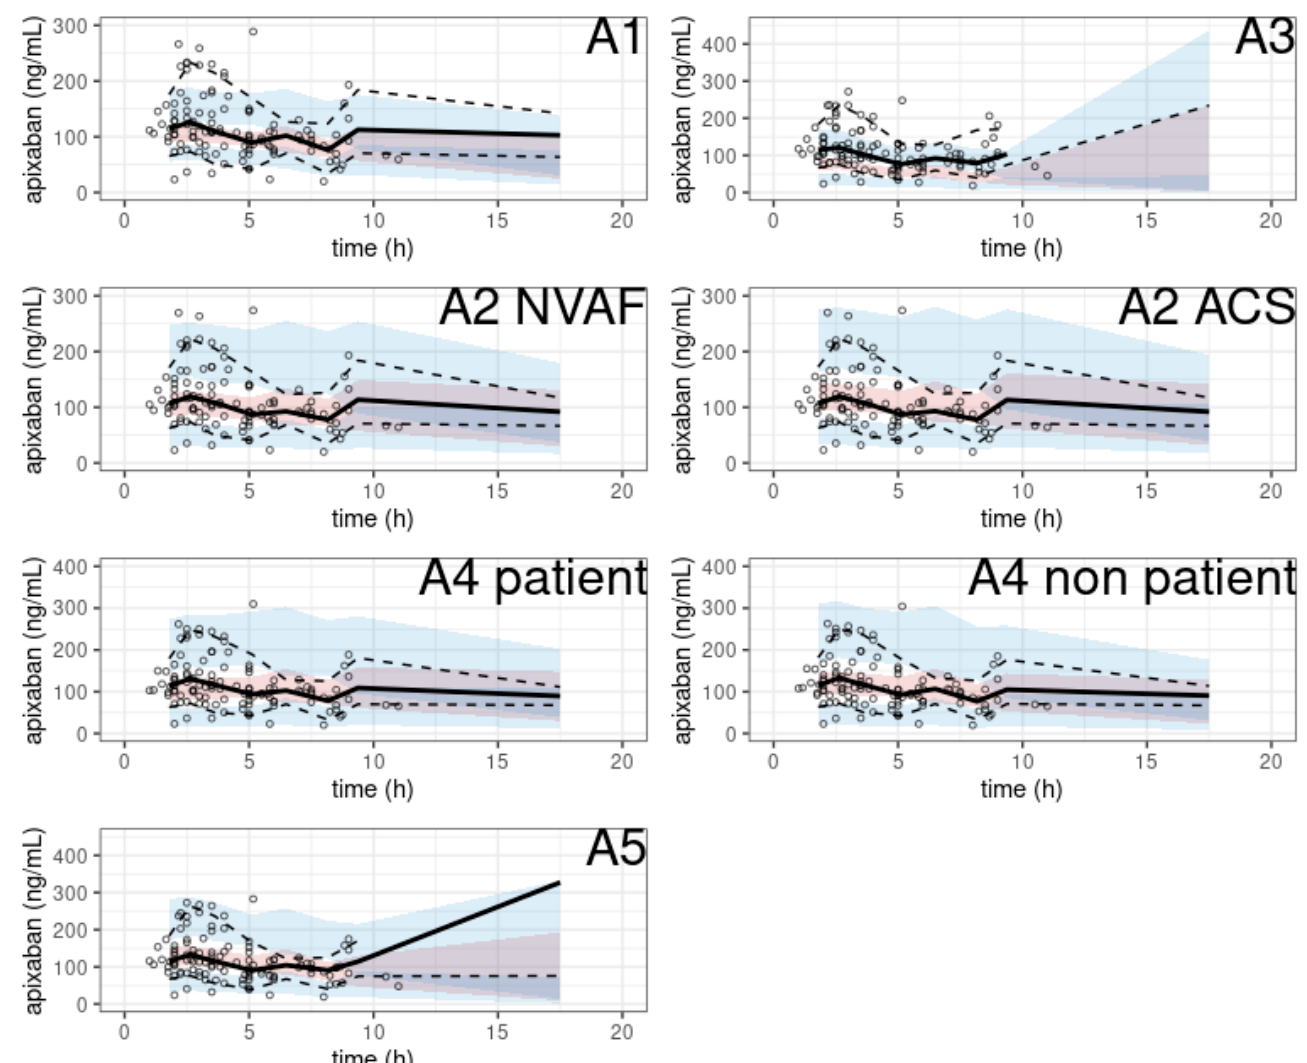
Figure 4. pcVPC of apixaban population pharmacokinetic studies applied to the external valida- tion dataset. tion